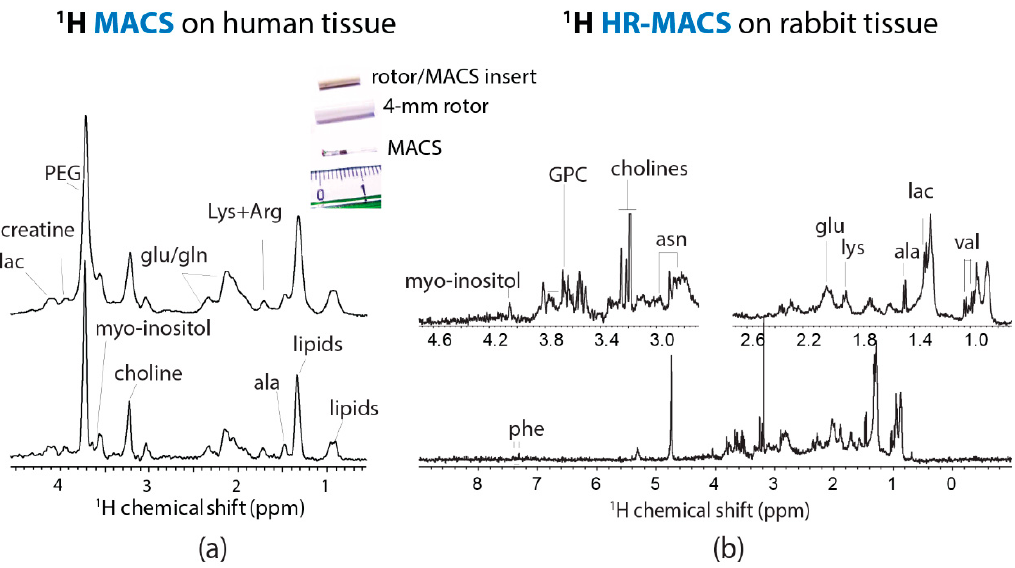
Figure 2. ( a ) 1 H MACS NMR of approximately 500 µg of human tissue at 400 MHz with MAS at 1360 Hz, with about 15 identified metabolites. Adapted with permission from [19]. Copyright (2012) American Chemical Society. ( b ) 1 H HR-MACS NMR of 250 µg rabbit kidney tissue at 500 MHz with MAS at 300 Hz. The improved spectral resolution offers a rich metabolic profile with about 20 identified metabolites. Adapted with permission from [24]. Copyright (2012) American Chemical Society.